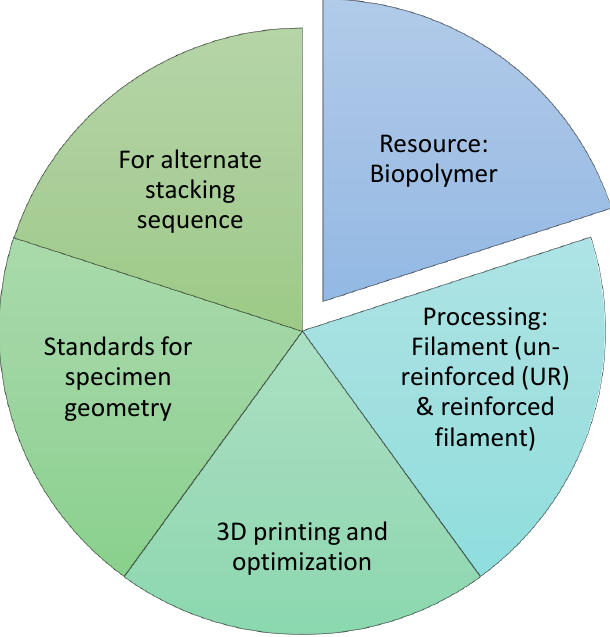
Figure 3. Visualisation of the underlying manuscript’s targeted research areas for the production of the PLA composites used in additive